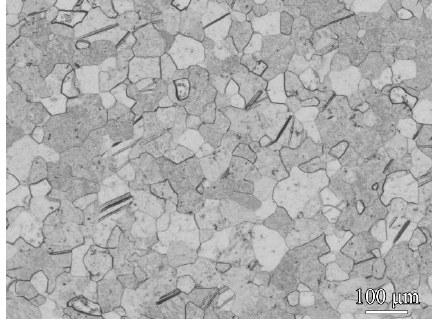
Figure 2. Optical micrograph of the CG sample.